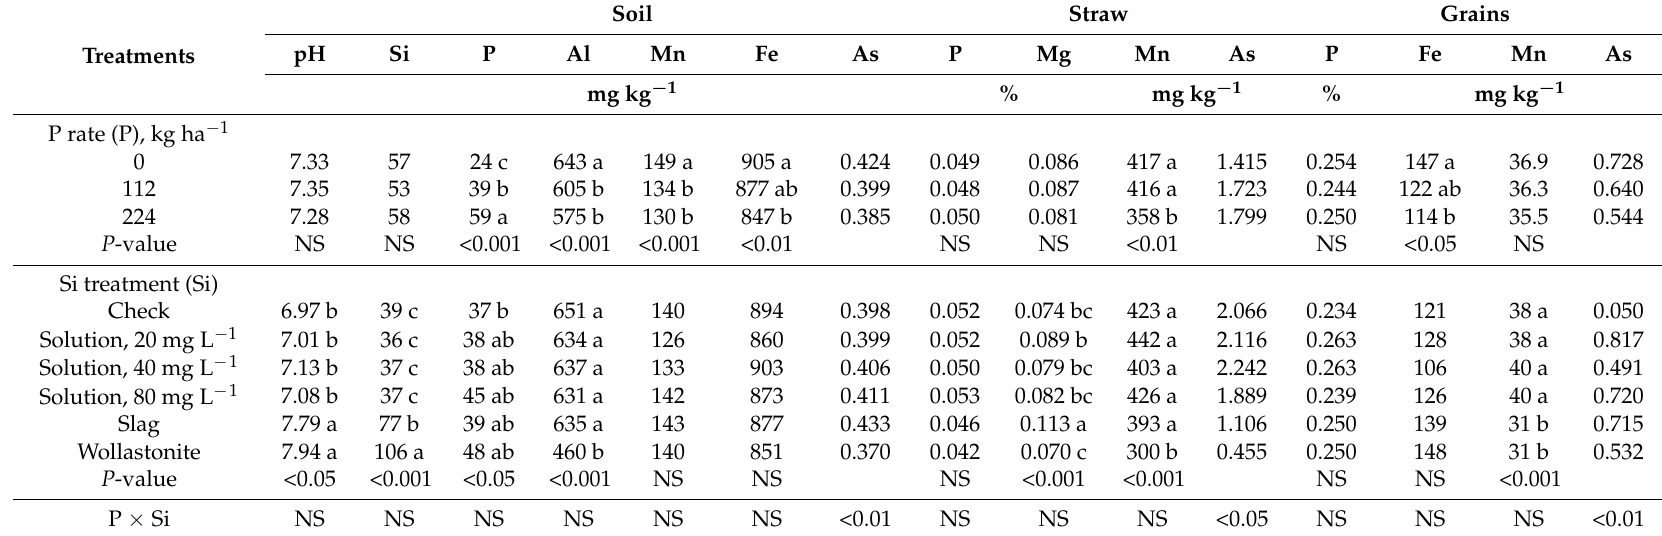
Table 2. Effect of phosphorus and silicon treatments on soil pH, and soil and plant nutrient